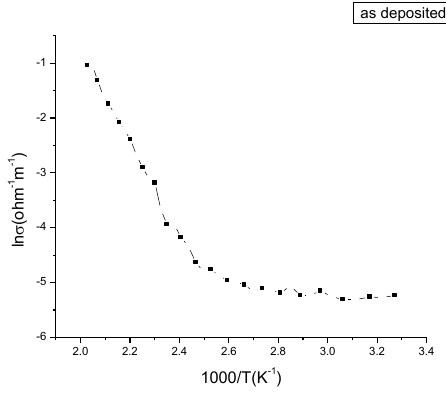
Figure 5 . Plot of lnσ versus 1000/T for the as deposited. Table 3. Activation energies of the H